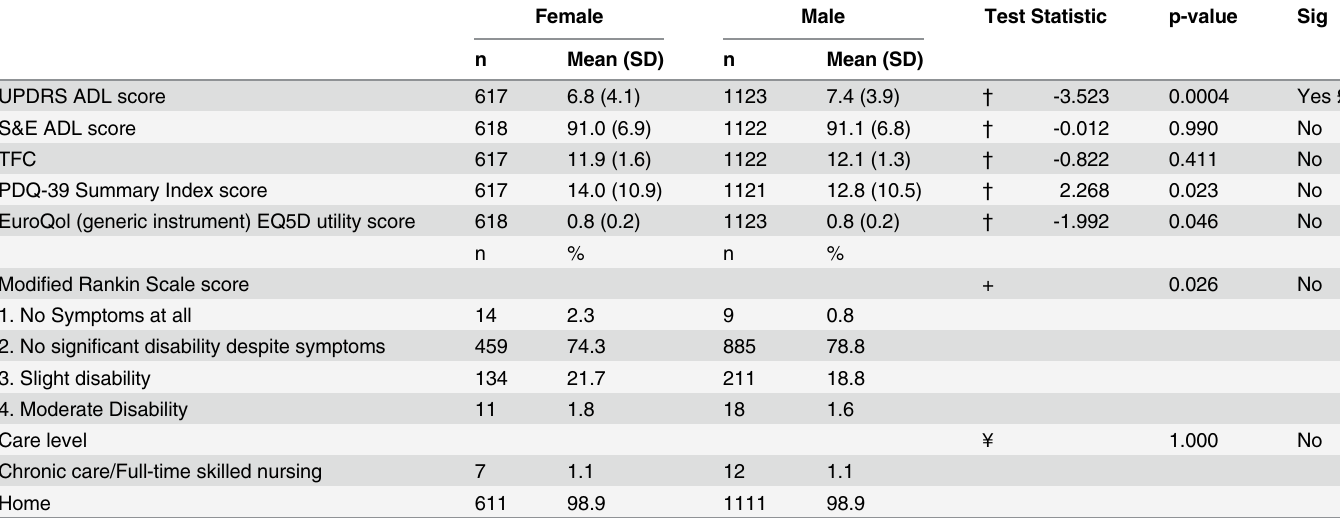
Table 4. Daily functioning features at the time of trial randomization ‡